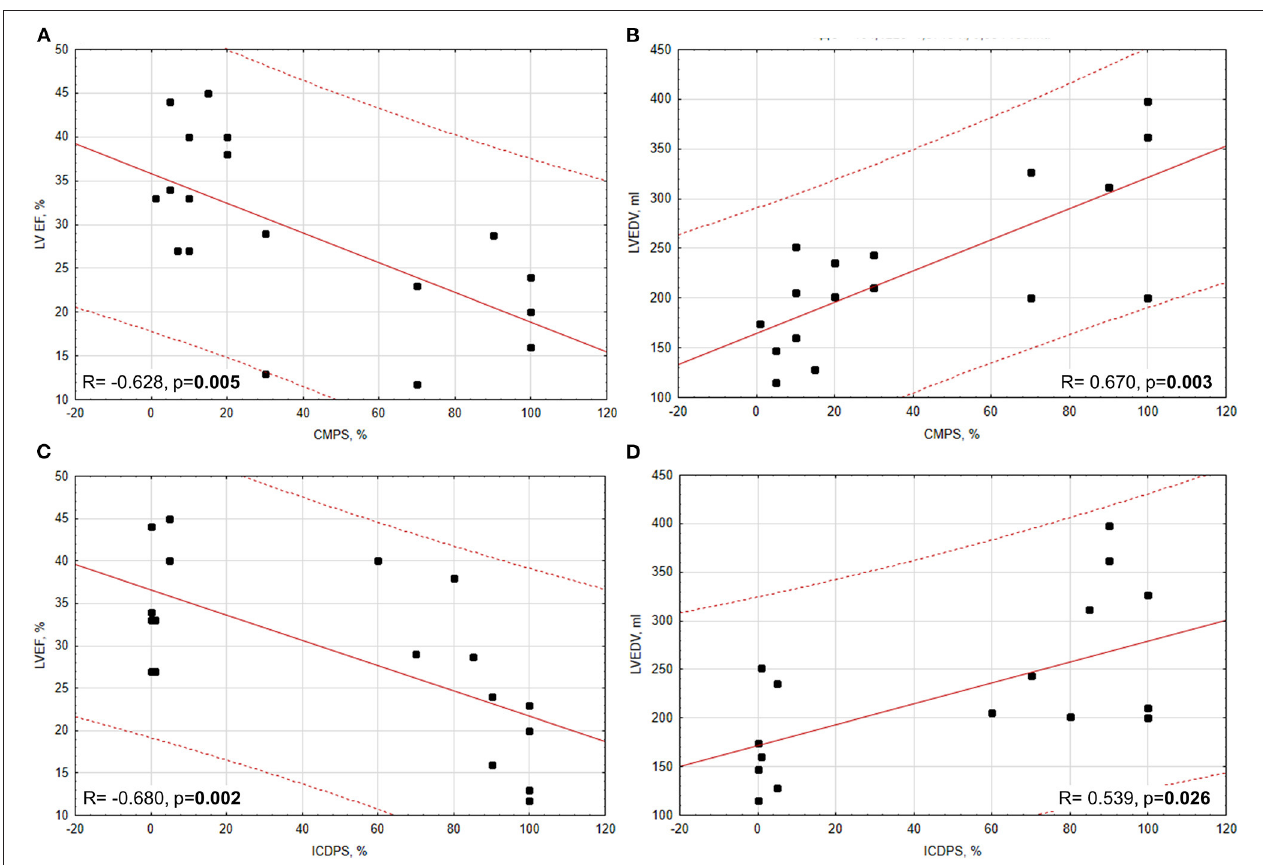
FIGURE 3 | Correlations between PD-L1 expression (CMPS, ICDPS) and echocardiographic parameters (LVEF and LVEDV). (A) Significant moderate negative correlation between CMPS and LVEF; (B) significant moderate positive correlation between CMPS and LVEDV; (C) significant moderate negative correlation between ICDPS and LVEF (D) significant moderate positive correlation between ICDPS and